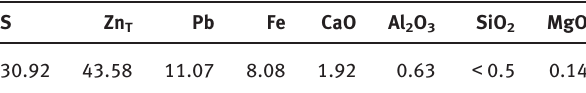
Table 1: Main chemical compositions of zinc sulfide ores (mass fraction, %).